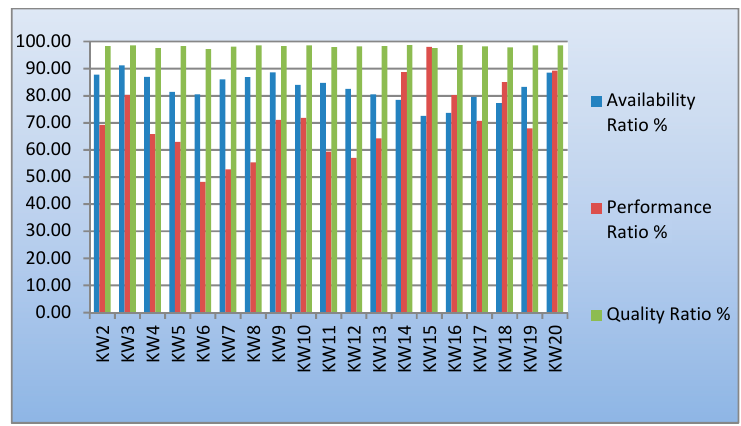
Figure 1. Evolution of overall equipment efficiency (OEE) factors in the first months of 2016.